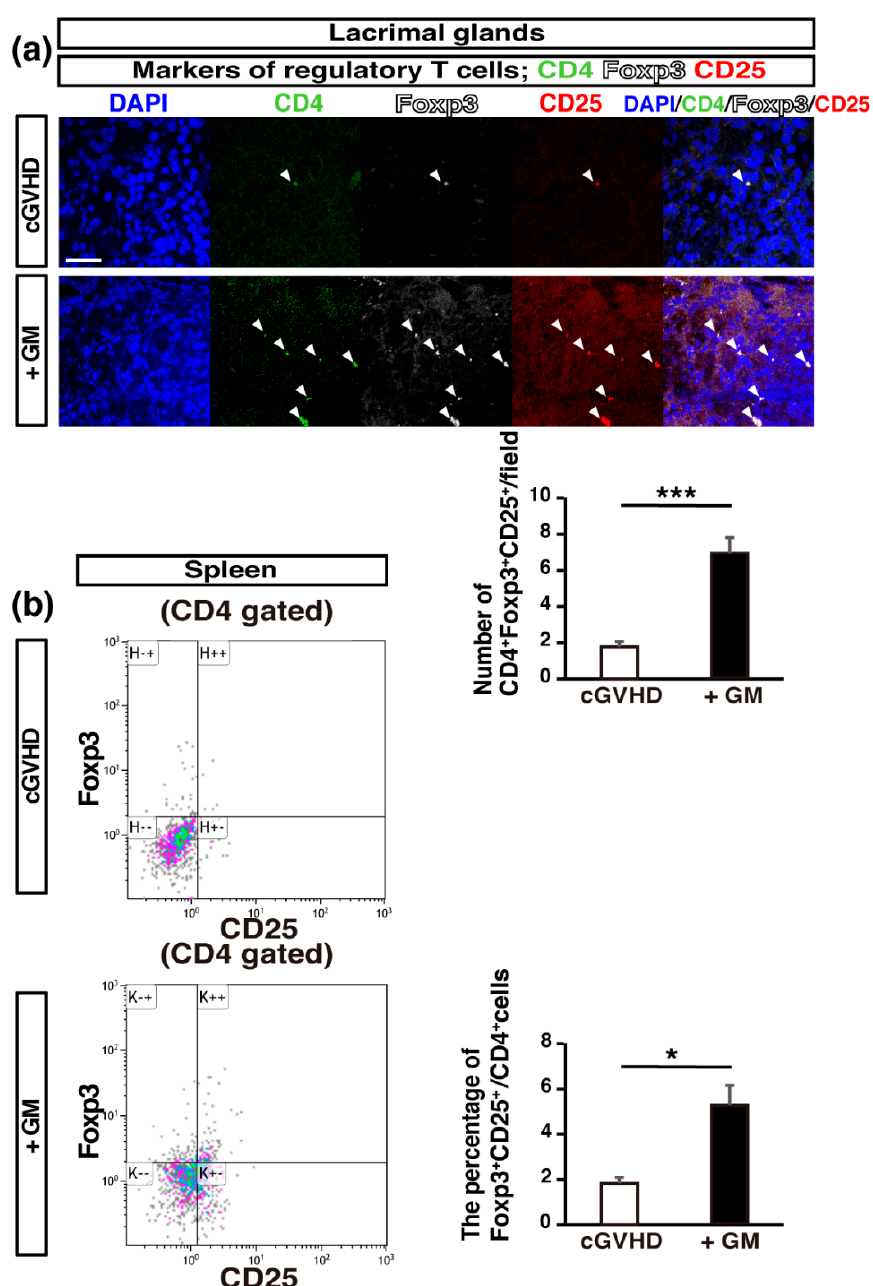
Figure 5. Regulatory T cells are retained in gentamicin-treated cGVHD mice: ( a ) sections of LGs from non-treated cGVHD mice ( n = 5, five fields per sample) and gentamicin-treated cGVHD mice (+GM) ( n = 5, five fields per sample) were stained for CD4 (green), Foxp3 (white), and CD25 (red). Data are presented as mean ± SEM. *** p <0.001, unpaired Student’s t -test. Scale bar, 50 µ m; ( b ) flow cytometry analysis of regulatory T cells (CD4 + Foxp3 + CD25 + cells) in the spleen ( n = 5 per group). Data are presented as mean ± SEM. * p <0.05, unpaired Student’s t -test.